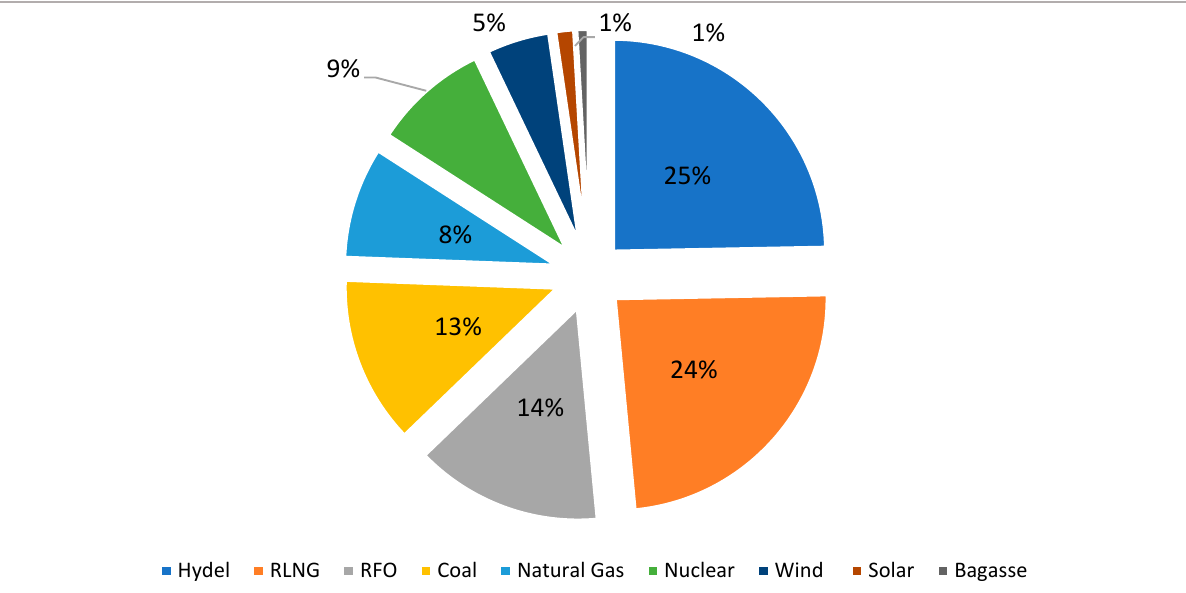
Figure 2. Energy sources in Pakistan’s energy mix.